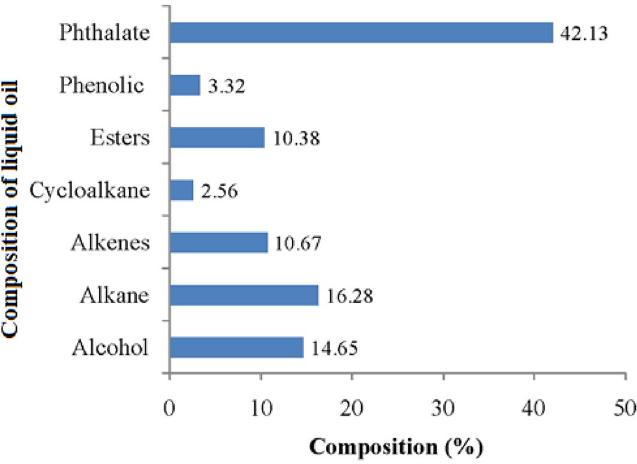
Figure 7. Nature of liquid oil derived from plastic based medical wastes identified by GC–MS analysis.